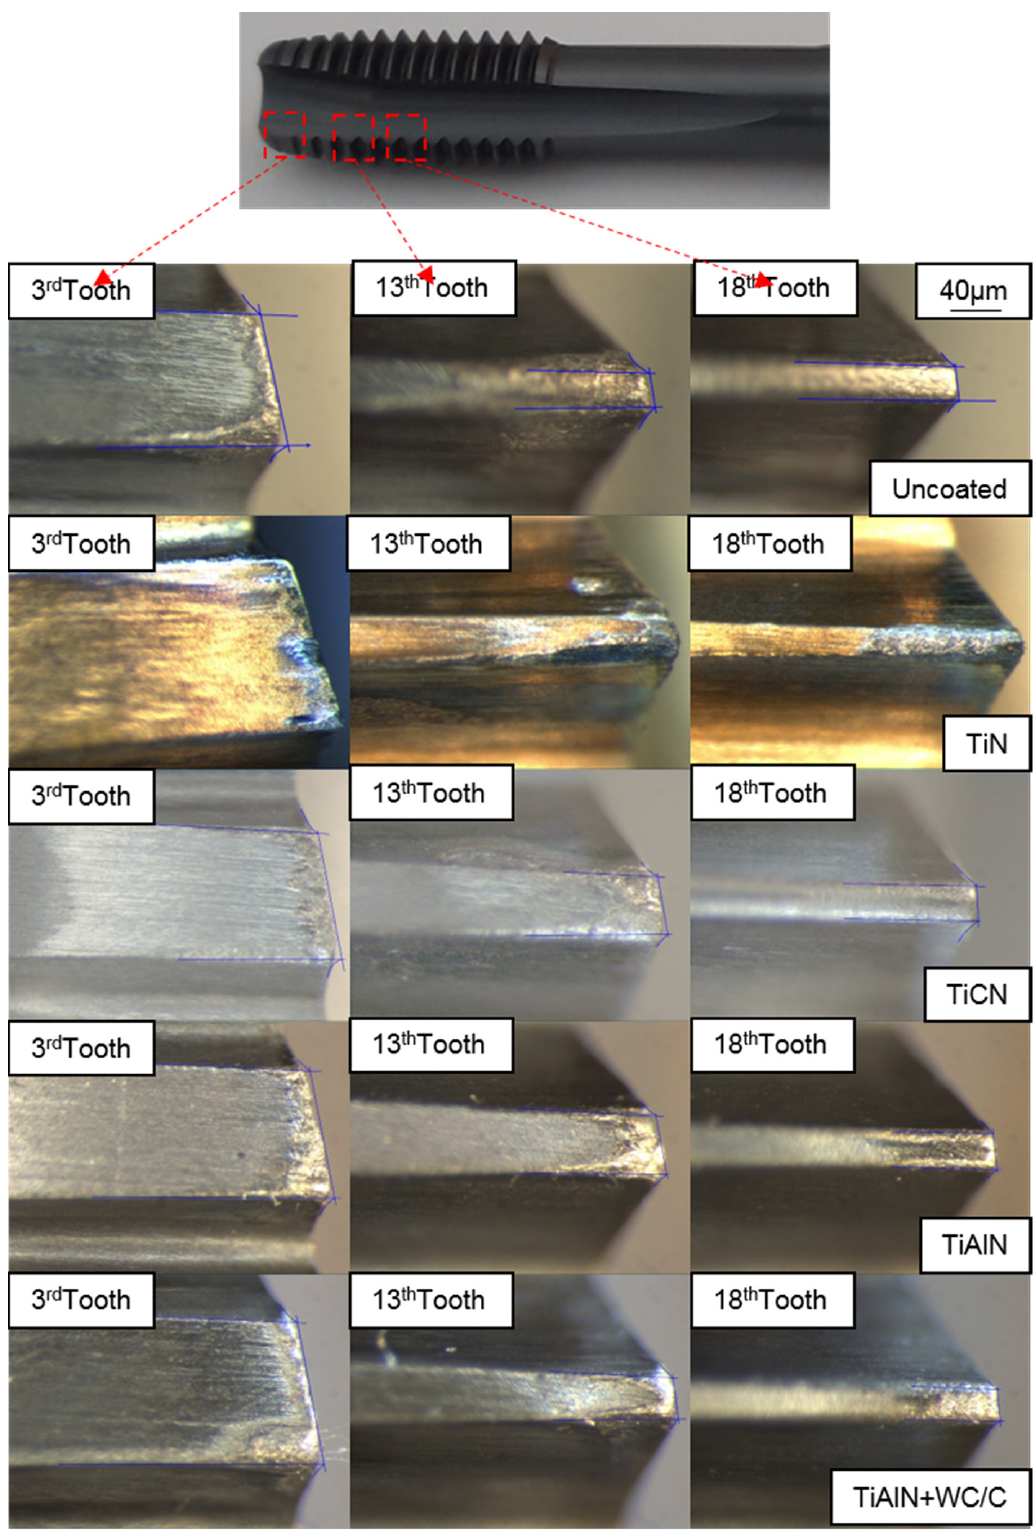
Figure 12. Microscope image of the 3rd, 13th and 18th teeth which belongs to conical, conical-cylindrical and cylindrical phases in the different coating taps.